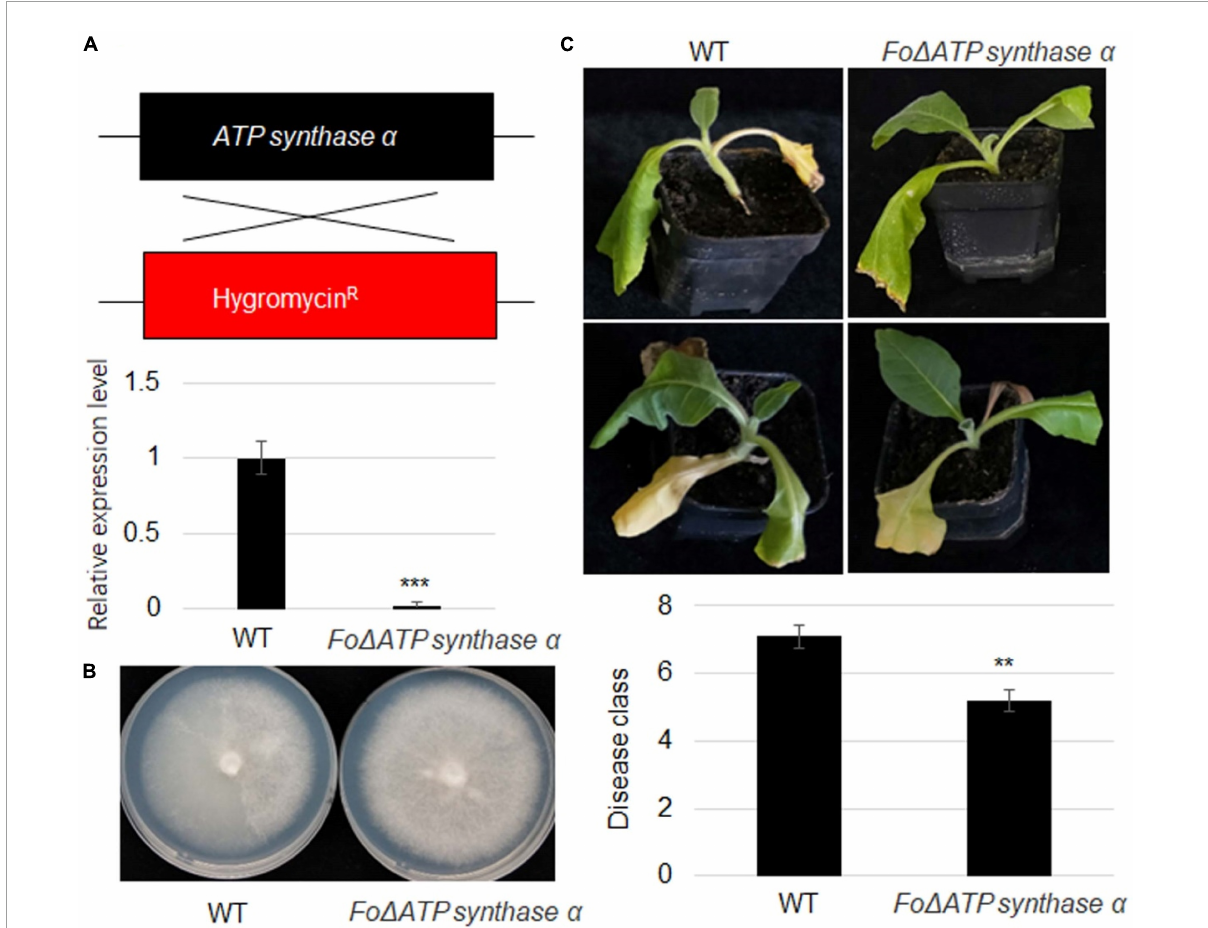
FIGURE5 An ATP synthase α mutation in Fusarium oxysporum severely reduces its virulence toward tobacco plants. (A) Scheme of recombination of FoATP synthase and hygromycin fragment in (cid:49) ATP synthase α mutant and relative expression level of FoATP synthase . (B) Representative images of wild-type and (cid:49) FoATP synthase mutant Fusarium oxysporum strains grown on PDA medium. (C) The phenotype of tobacco plants upon inoculation of WT and (cid:49) FoATP synthase mutant strains of Fusarium oxysporum . The disease class of both types of tobacco plants was calculated, ** P < 0.01; *** P <